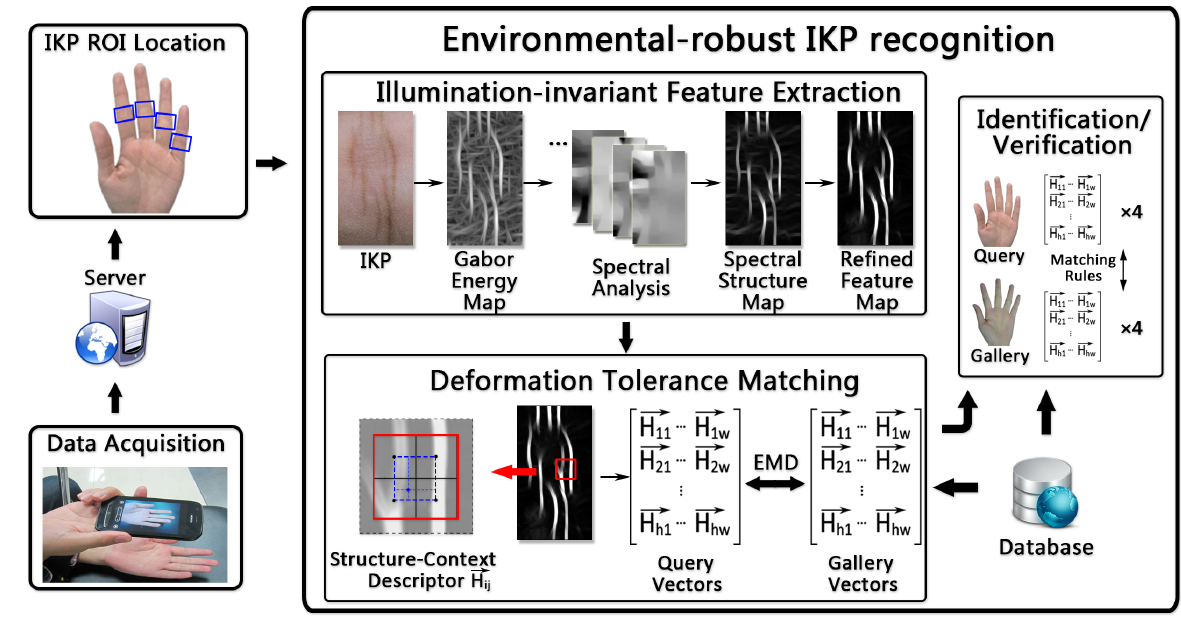
Figure 2. System overview of our identification